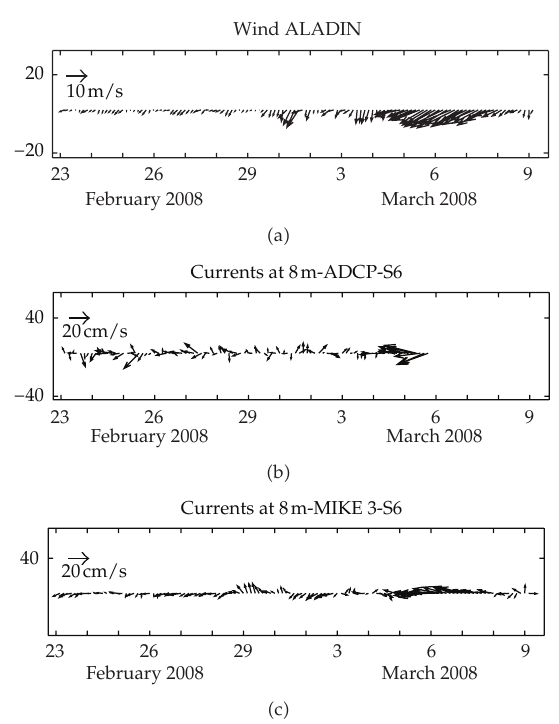
Figure 7: As in Figure 5 but for the ADCP station